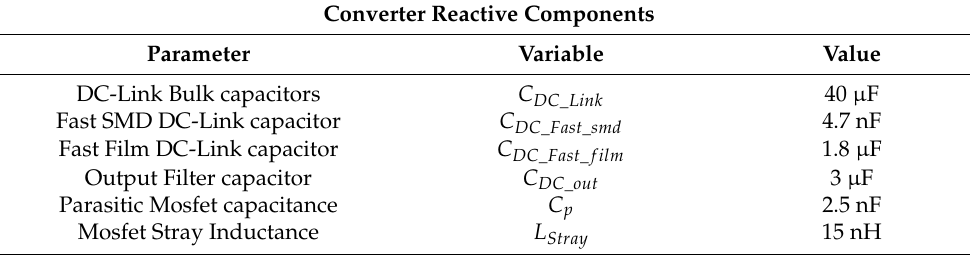
Table 3. Parameters of converter reactive